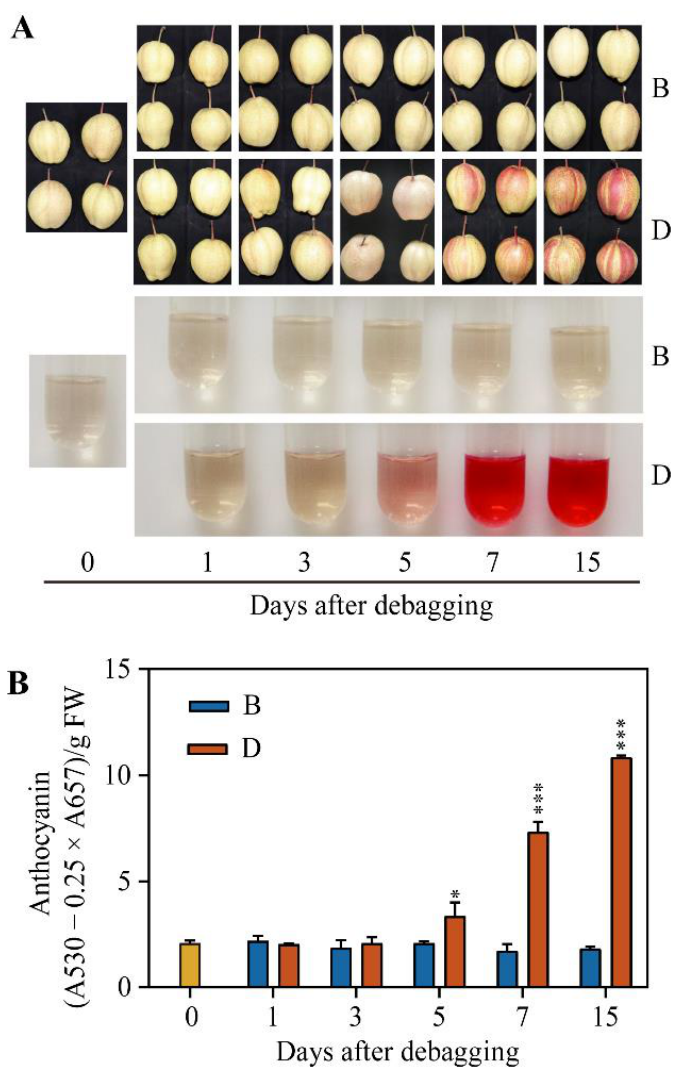
Figure 1. Debagging promotes anthocyanin accumulation in the peel of ‘Red Zaosu’ pear. ( A ) Color changes in ‘Red Zaosu’ pear. ‘0’ was the initial sample before debagging. ‘B’ represents bagging samples, while ‘D’ indicates debagging samples. ( B ) Changes in the anthocyanin content after debagging. Error bars denote the standard deviations. Asterisks above the bars indicate significant differences (*** p < 0.001, * p < 0.05) obtained by two-tailed Student’s t -test within each